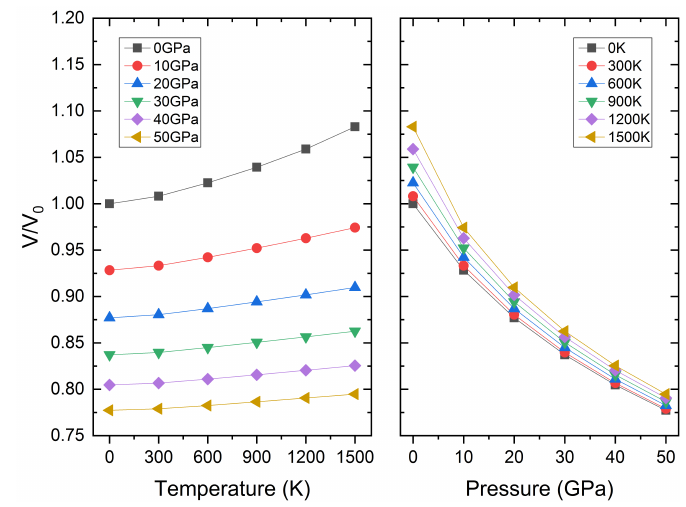
Figure 9. The normalized volume V/V 0 variation with temperature ( left ) and pressure ( right ) for Ti 2 NiIn.